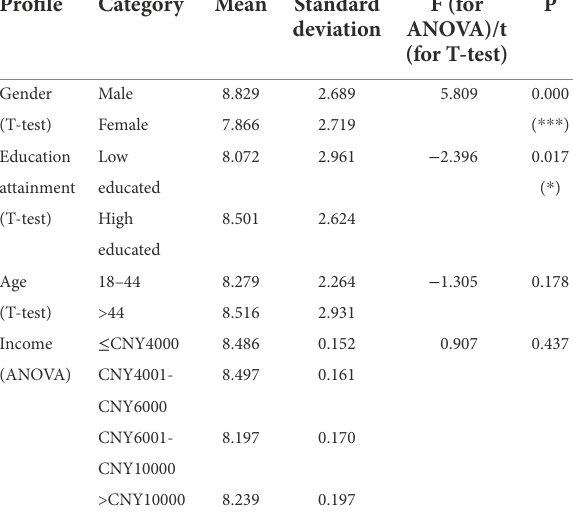
TABLE 2 Statistical results of the descriptive variables. Factor